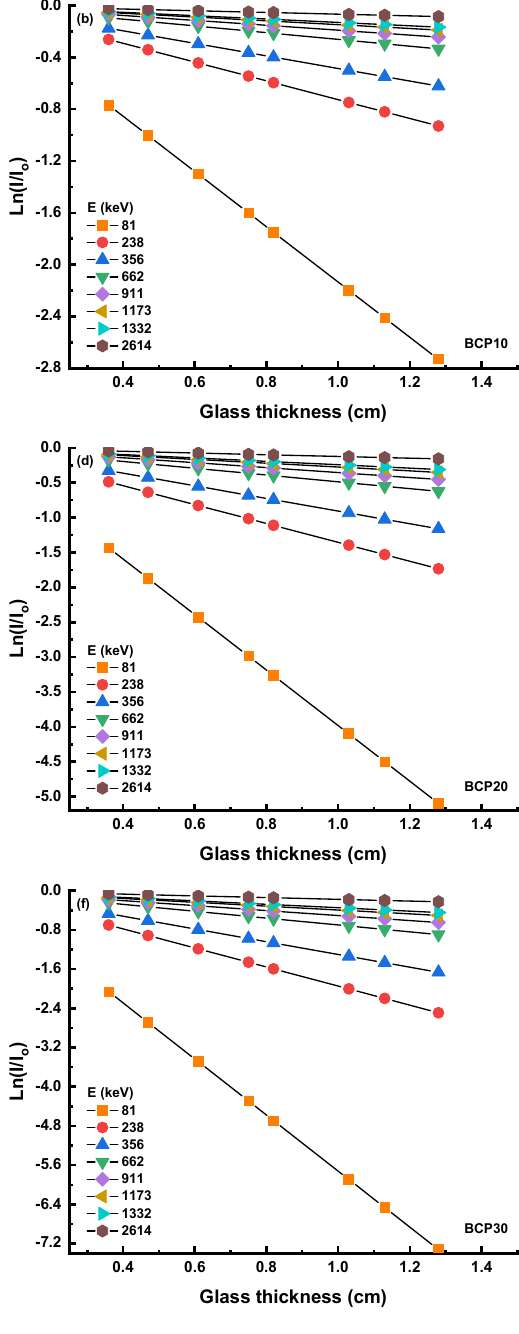
Figure 4. ( a – f ) Graph of Ln(I/I o ) against glass thickness at selected photon energy. Figure 5a,b shows the G LAC and G MAC values for BCP5, BCP10, BCP15, BCP20, BCP25, and BCP30 samples at 81, 238, 356, 662, 911, 1173, 1332, and 2614 keV, respectively. If you look at the graph in Figure 5a,b, you will see that the G LAC and G MAC values rise when the concentration of Bi2O3 rises. This is something that can be observed. The xBi 2 O 3 – (40−x)CaO-60P 2 O 5 glass system has the greatest G LAC and G MAC values, which are,